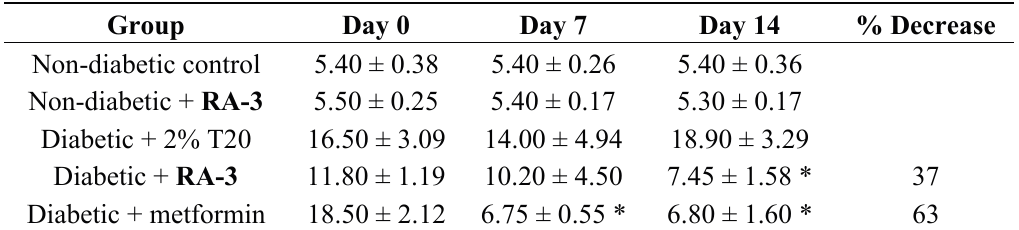
Table 1. Effect of RA-3 on blood glucose levels (mmol/L) of diabetic